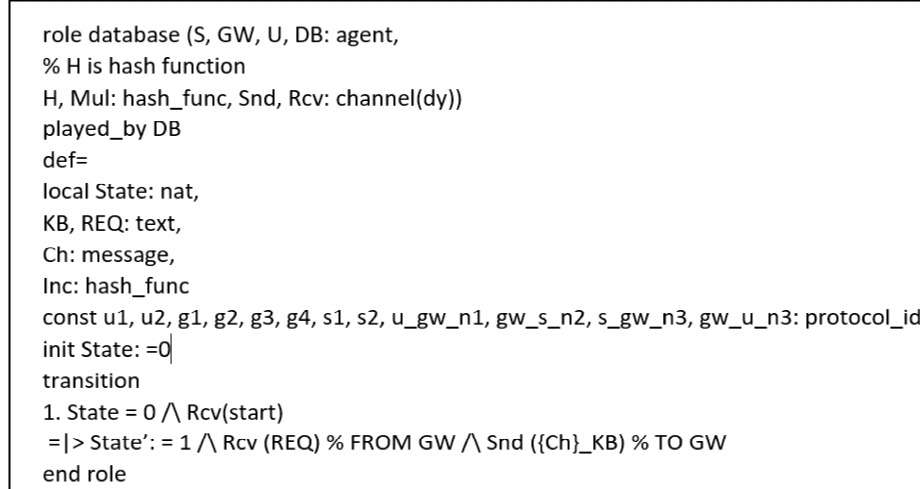
Figure A5. Role of the session and environment.